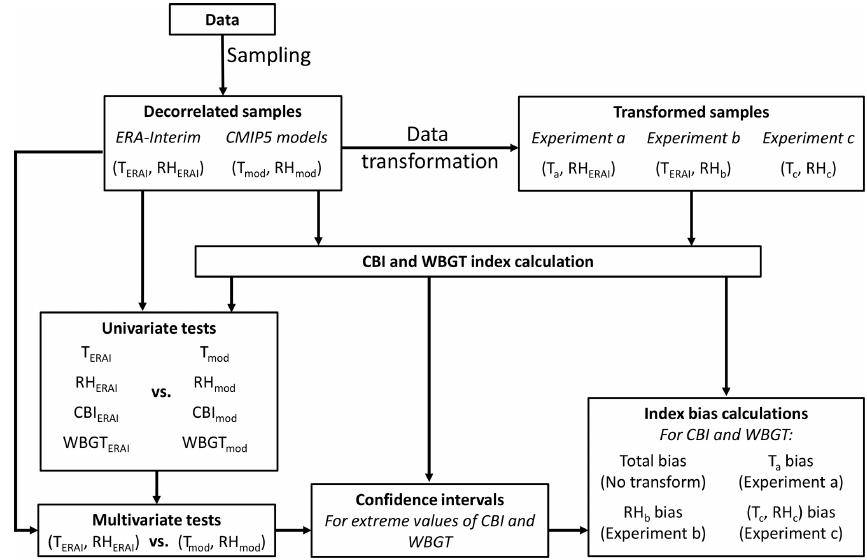
Figure A2. Block diagram showing the data and methods used. Temperature ( T ) and relative humidity (RH) decorrelated samples from CMIP5 models’ biases are analysed using univariate and multivariate statistical tests using ERA-Interim as reference dataset. We also create transformed CMIP5 model samples, which allow for assessing the bias in the extreme values of the hazard indicator (CBI and WBGT) driven by biases in T , RH, and their statistical dependence.